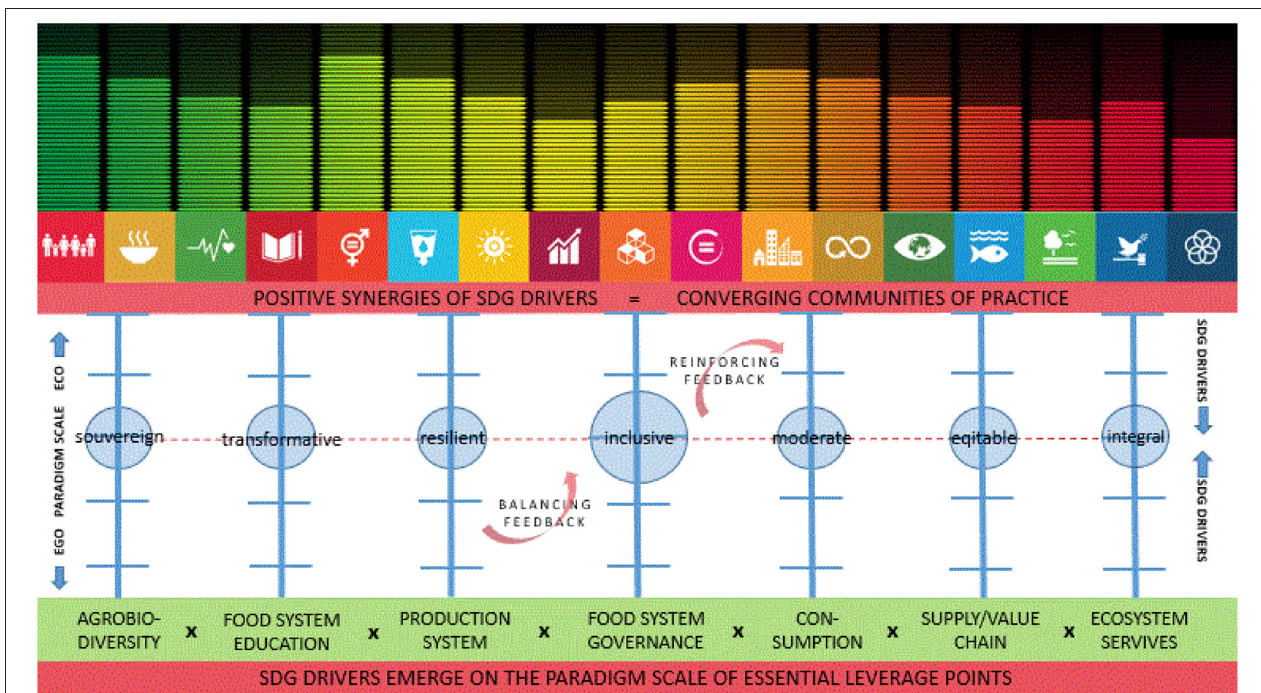
FIGURE 5 | Sustainable development goal (SDG) driver algorithm based on a mindset model. Aligned social, natural, and built capital stocks and flows leading to distributed positive externalities/emerging properties in food systems.